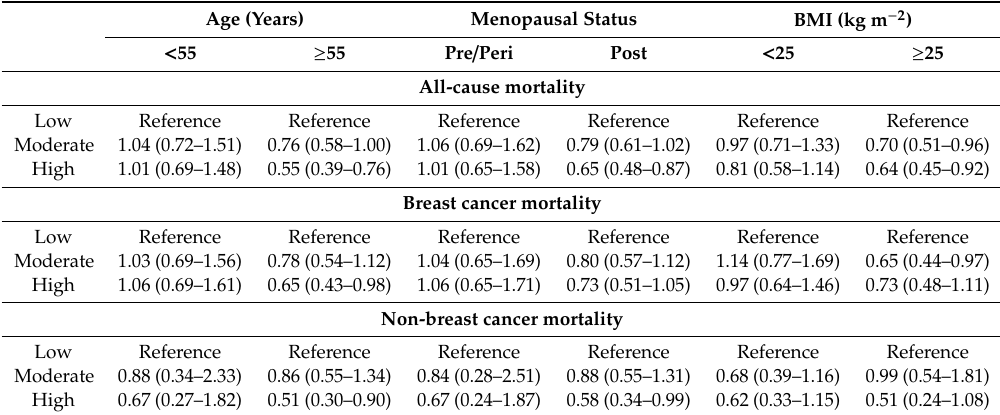
1 Estimated using Cox Proportional Hazard Model adjusted for area of residence at diagnosis, calendar period of